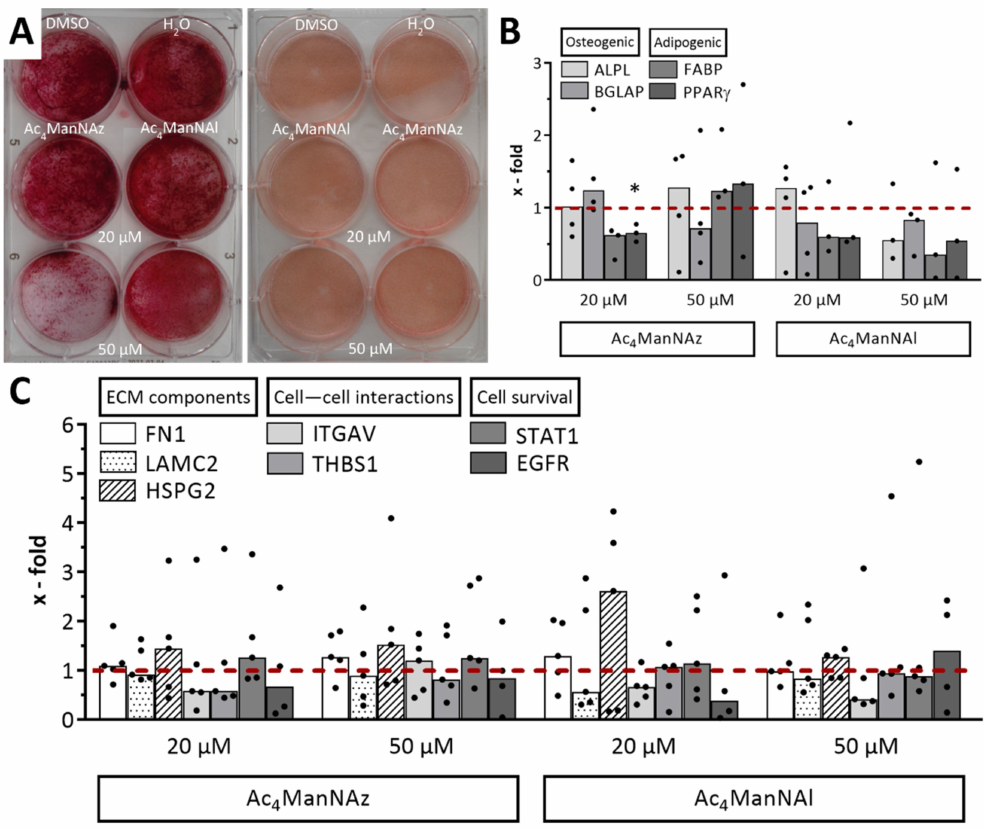
Figure 4. Differentiation capacity and gene expression of hMSC-TERT after 72 h incubation with Ac 4 ManNAz or Ac 4 ManNAl. ( A ) Alizarin Red and Oil Red staining after two weeks of osteogenic or adipogenic differentiation. Representa- tive images of three independent experiments are shown. ( B ) Gene expression analysis of alkaline phosphatase (ALPL) and bone gamma carboxyglutamate protein (BGLAP) (osteogenic markers) as well as fatty acid binding protein (FABP) and peroxisome proliferator activated receptor gamma (PPAR γ ) (adipogenic markers) relative to DMSO-treated control (dashed line). Datasets (median with individual values) were tested for significance using two-tailed paired t -test ( p < 0.05 depicted as *). ( C ) Gene expression analysis of fibronectin (FN1), laminin subunit gamma 2 (LAMC2), heparan sulfate proteoglycan (HSPG2), integrin subunit alpha V (ITGAV), thrombospondin 1 (THBS1), signal transducer and activator of transcription 1 (STAT1), and epidermal growth factor receptor (EGFR) relative to DMSO-treated control (dashed line). Extracellular matrix (ECM). Datasets (median with individual values) were tested for significance using two-tailed paired t